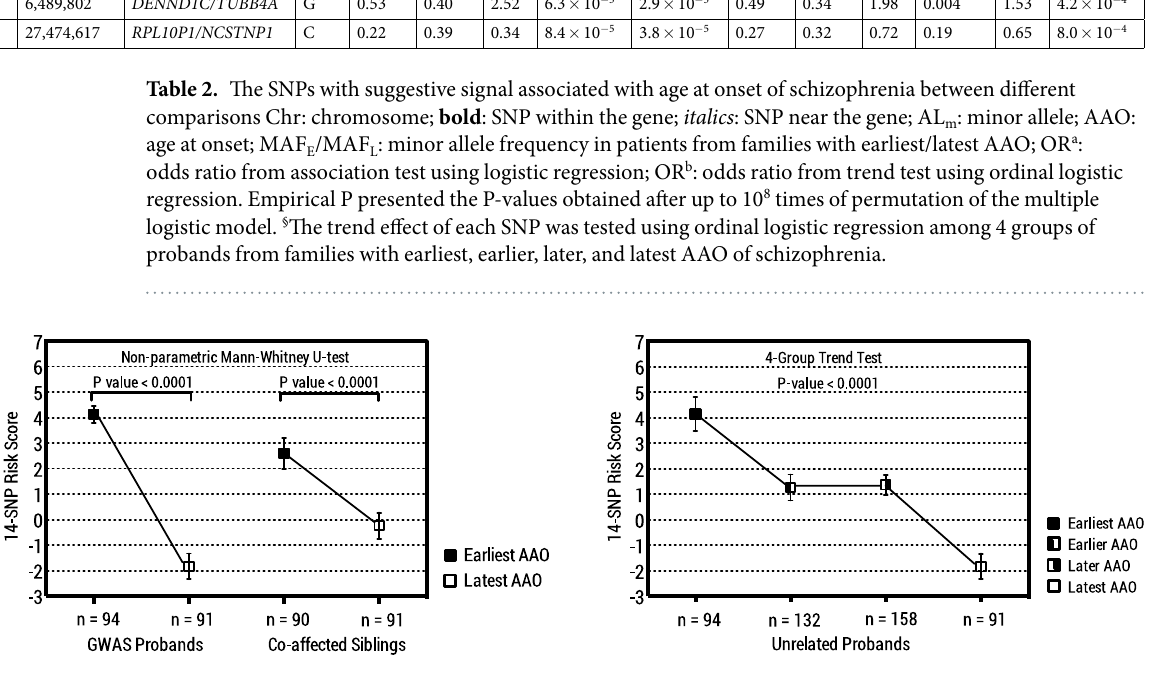
Figure 2. Multi-SNP genetic risk scores composed of the 14 SNPs associated with age at onset of schizophrenia. The left panel shows the difference of the 14-SNP genetic risk scores among both probands (94 with earliest and 91 with latest AAO) and co-affected siblings (90 with earliest and 91 with latest AAO) between two family groups, with a P-value < 0.0001 using the non-parametric Mann-Whitney U-test. The right panel shows a significant trend of the 14-SNP genetic risk scores among the probands from 4 family groups with a gradient AAO (earliest, earlier, later, and latest AAO), with a P-value < 0.0001 using the trend test using linear